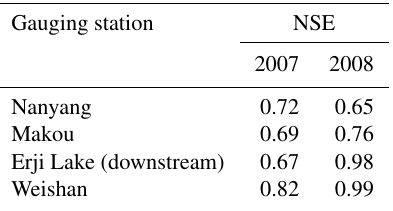
Table 1. Statistical evaluation of model performance for water level simulations at selected gauging stations for 2007 and 2008 flood